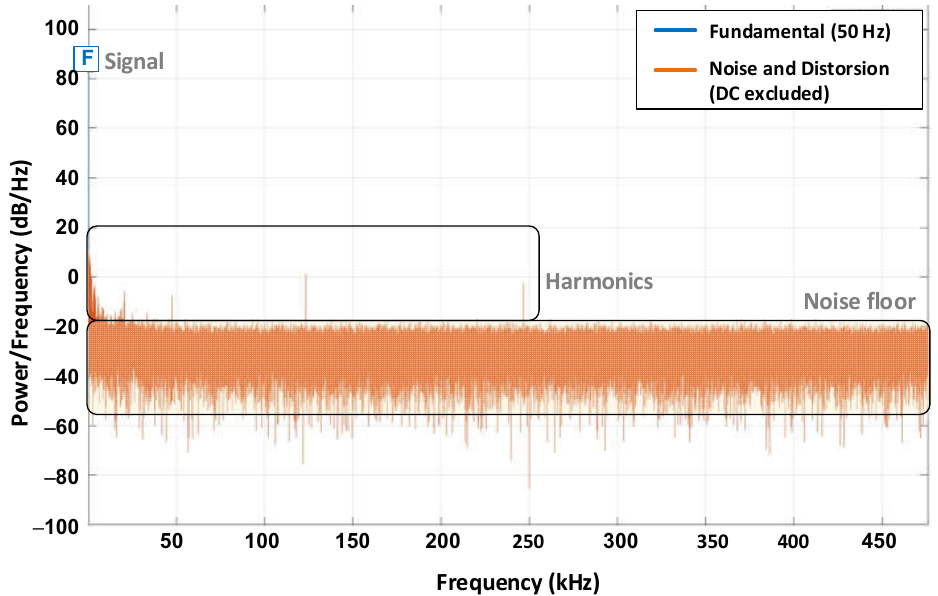
Figure 4. FFT obtained with the sinewave-input test of 0.45 V and 50 Hz.